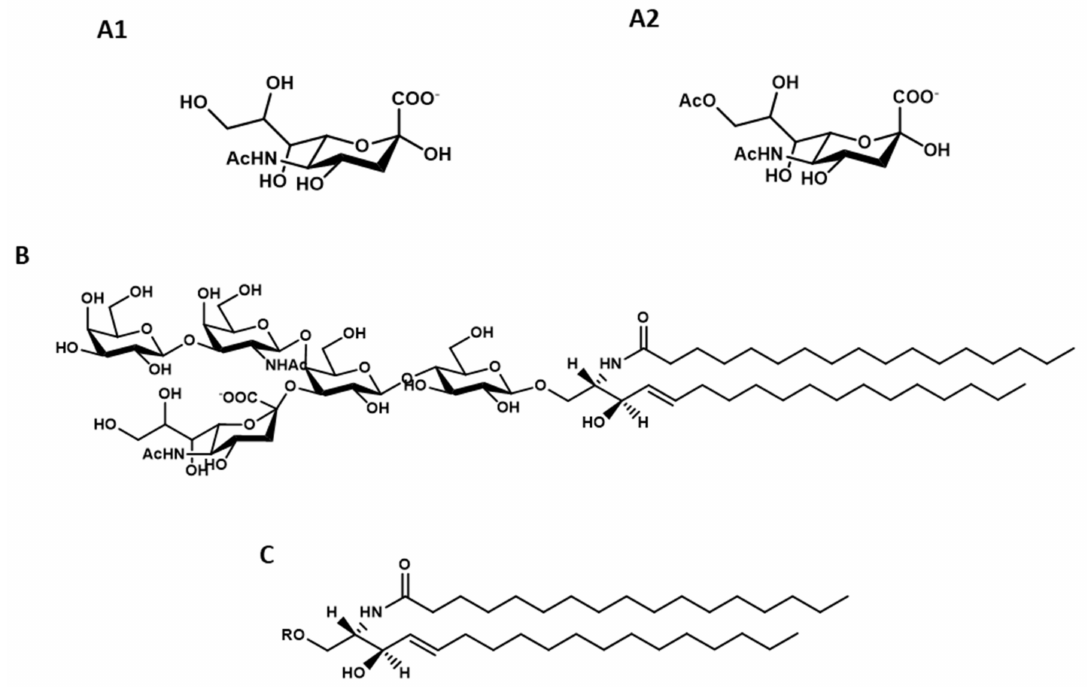
Figure 1. Structure of: N -acetylneuraminic acid, Neu5Ac ( A1 ), N -acetyl-9-acetylneuraminic acid, Neu5,9Ac 2 ( A2 ), ganglioside GM1, II 3 Neu5AcGg 4 Cer ( B ), ceramide, Cer R = oligosaccharide chain ( C